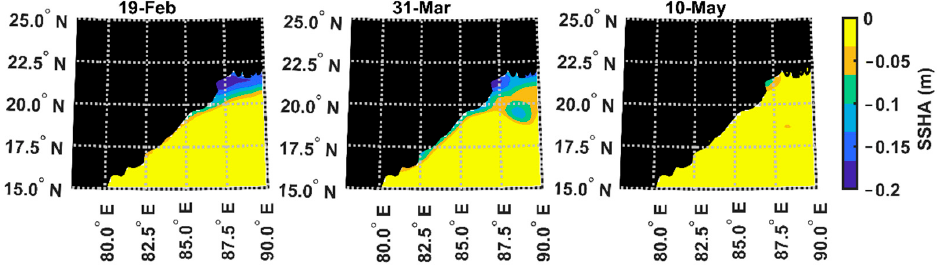
Figure 13. Decadal climatology (2009 to 2018) of unfiltered positive SSHA in the northwestern BoB during the first upwelling Kelvin wave period.